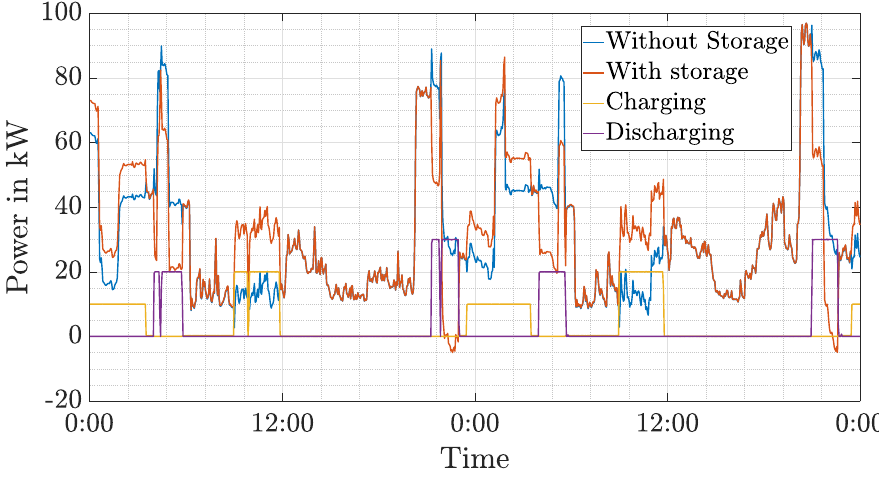
Figure 10. Measurement data for the fixed schedule